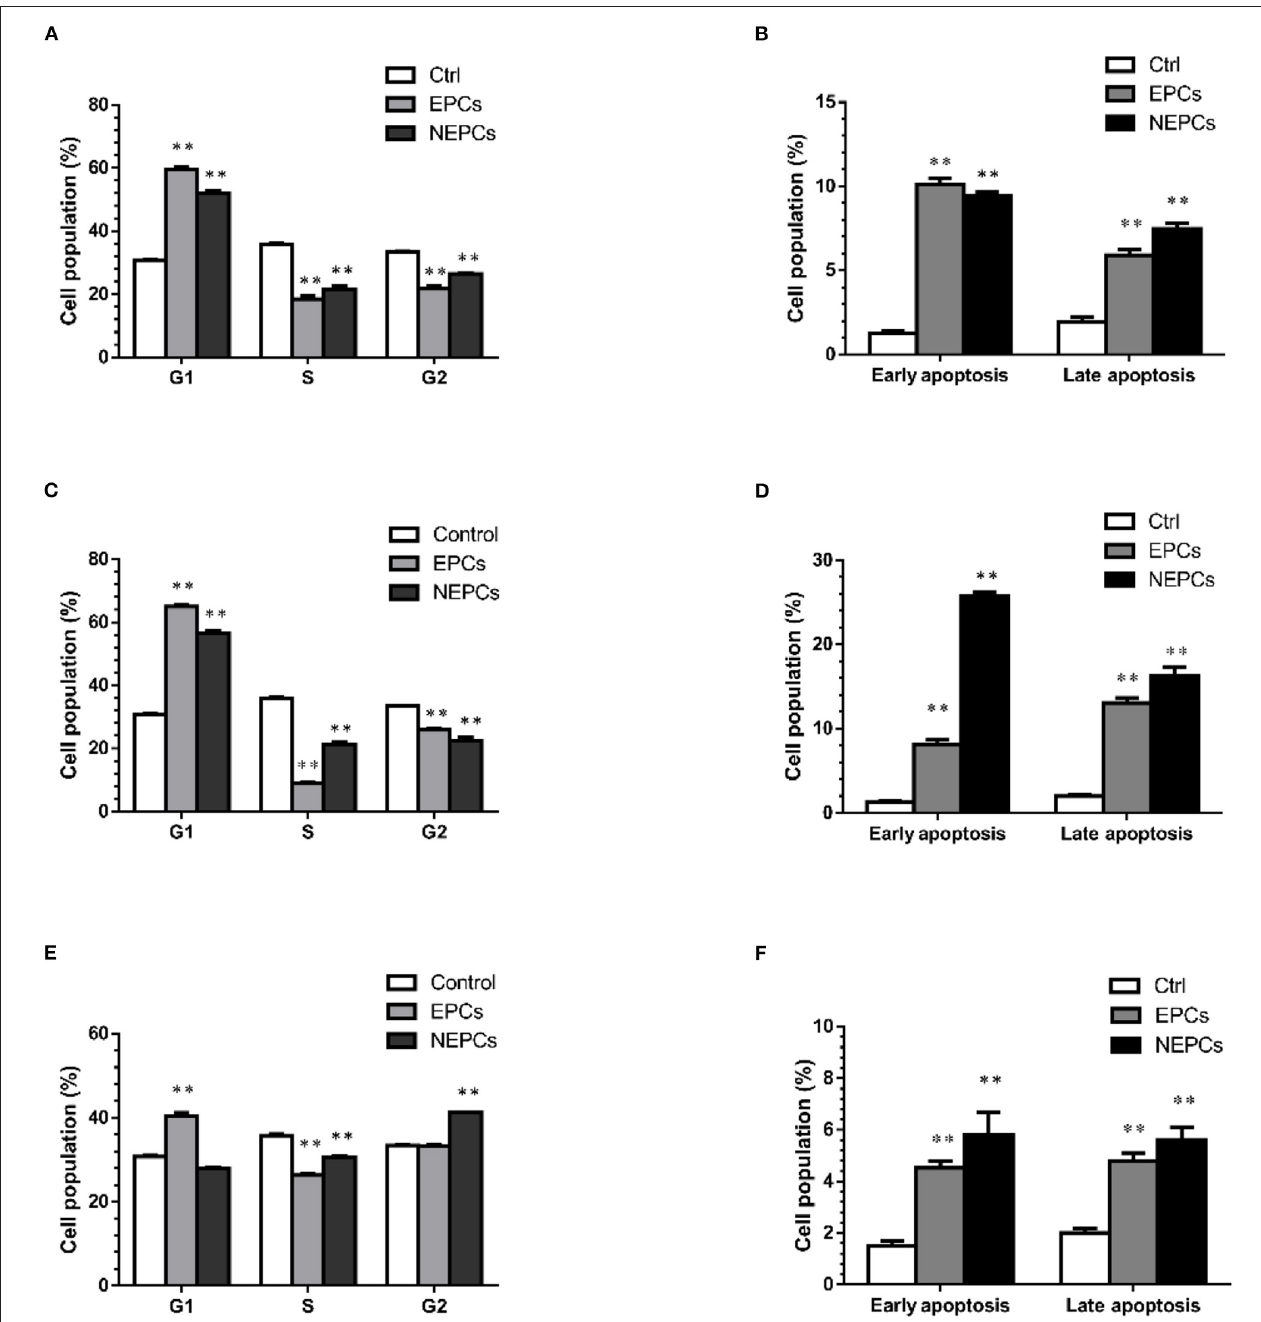
FIGURE 7 | Quantification of cell cycle distribution posed to EPCs and NEPCs from L. japonica (A) , U. lactuca (C) and P. tenera (E) . Quantification of early and late apoptosis posed to EPCs and NEPCs from L. japonica (B) , U. lactuca (D) , P. tenera (F) . Results were presented as mean ± SD ( n = 3). ** p < 0.01 indicate statistically differences from untreated